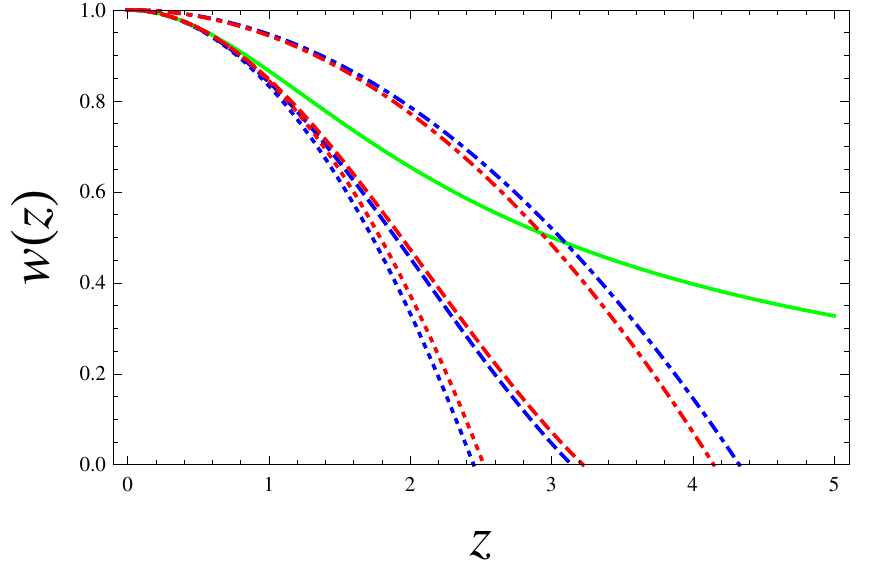
( z ) GR ( z ) . The red lines GR ( z ) (dotted line) and w (1) ( z ) f ( R ) f ( R ) ( z ) ) and GR ( z ) ) for a uniform f ( R ) = 0 . 4 0